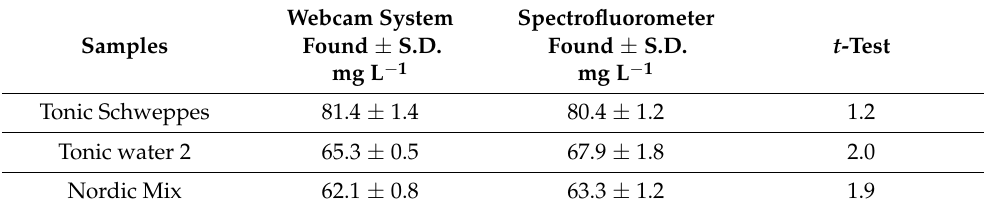
Table 3. Quinine concentrations obtained from fluorimetric measurements in food samples (n = 3). Spectrofluorometer Webcam System Found ± Samples Found ± S.D. mg L − 1